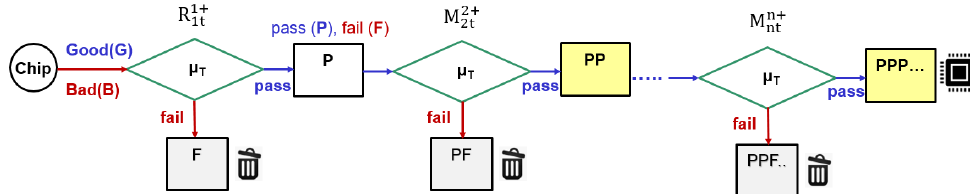
Figure 9. Test decision diagram for multiplex testing ( M n +